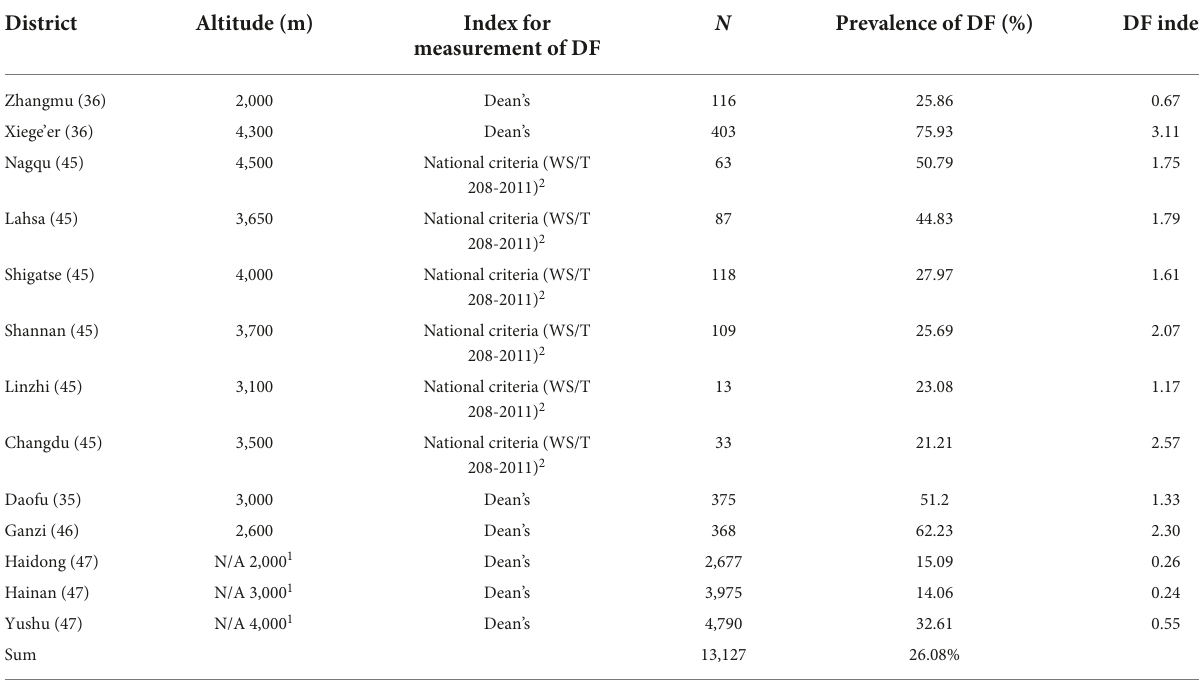
TABLE 3 Prevalence of dental fluorosis in different